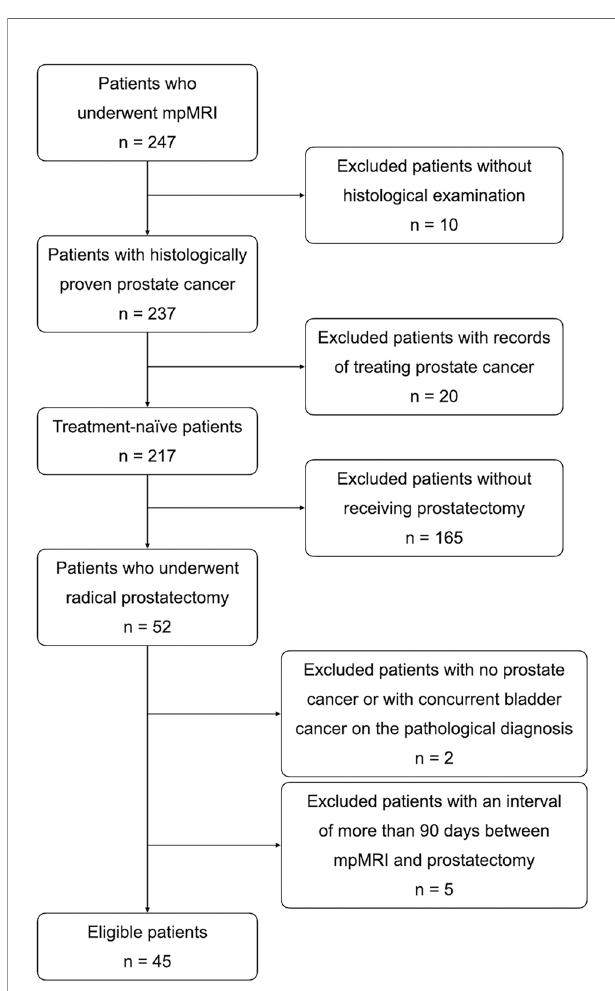
FIGURE 1 | Flow diagram of the enrollment of the 45 patients selected by applying inclusion and exclusion